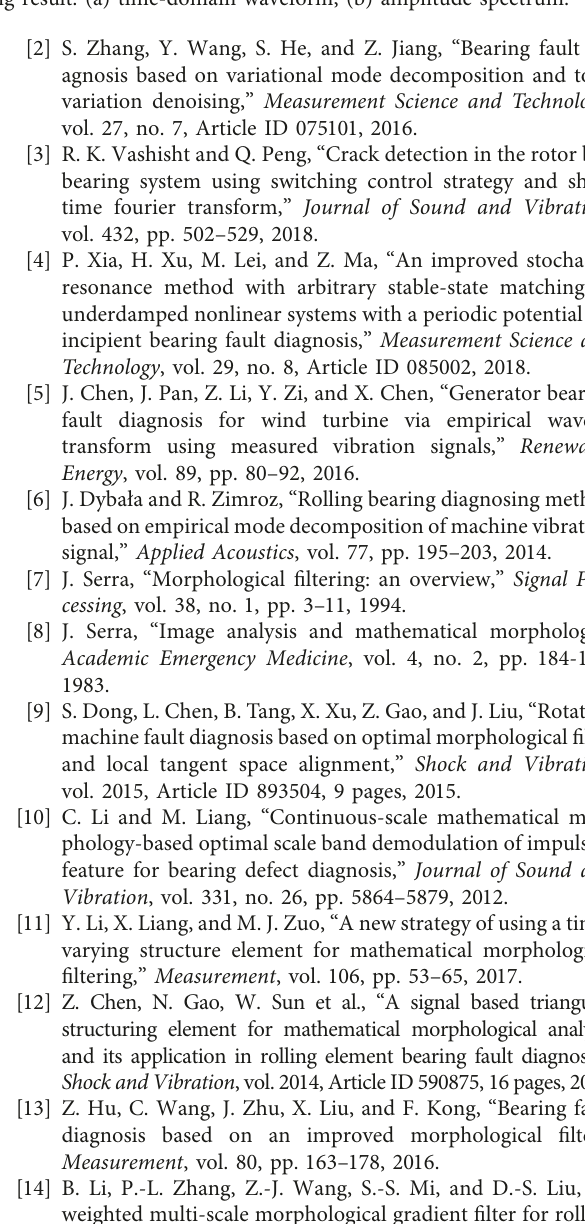
Figure 22: Case 2: waveform and spectrum of MCMFH filtering result: (a) time-domain waveform; (b) amplitude